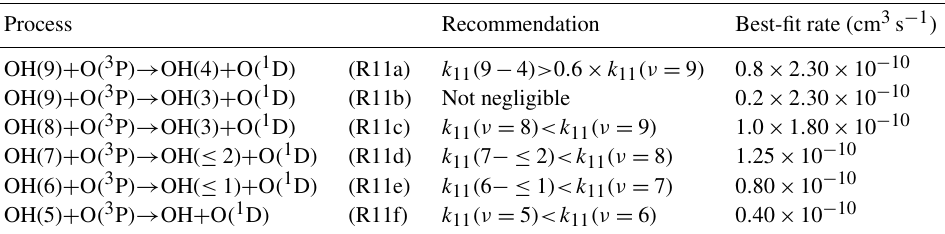
Table 3. Empirically determined branching ratios of OH( ν ) + O ( 3 P ) → OH( ν ’) + O ( 1 D ) of the best-fit model based on the OH(6-2) VER, OH(5-3) + OH(4-2) VER, and OH(3-1) VER observations.